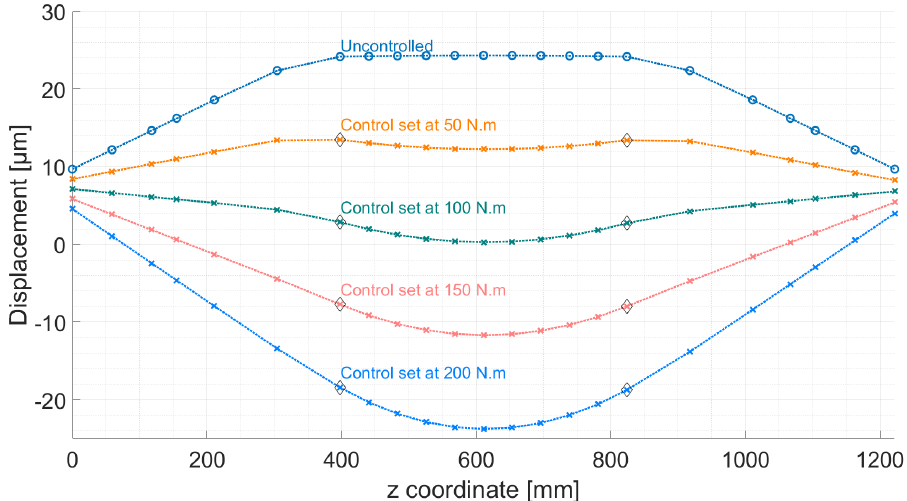
Figure 11. Rotor radial displacement at 2400 RPM for different control moments and a 180 g mm